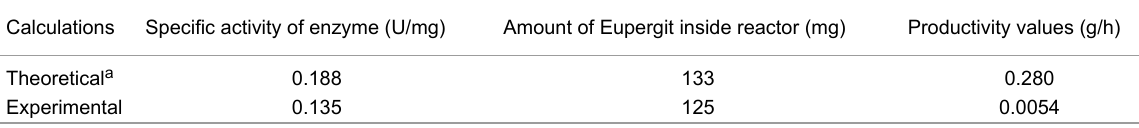
Table 2: Comparison of productivity between the theoretical calculations and experimental observations.